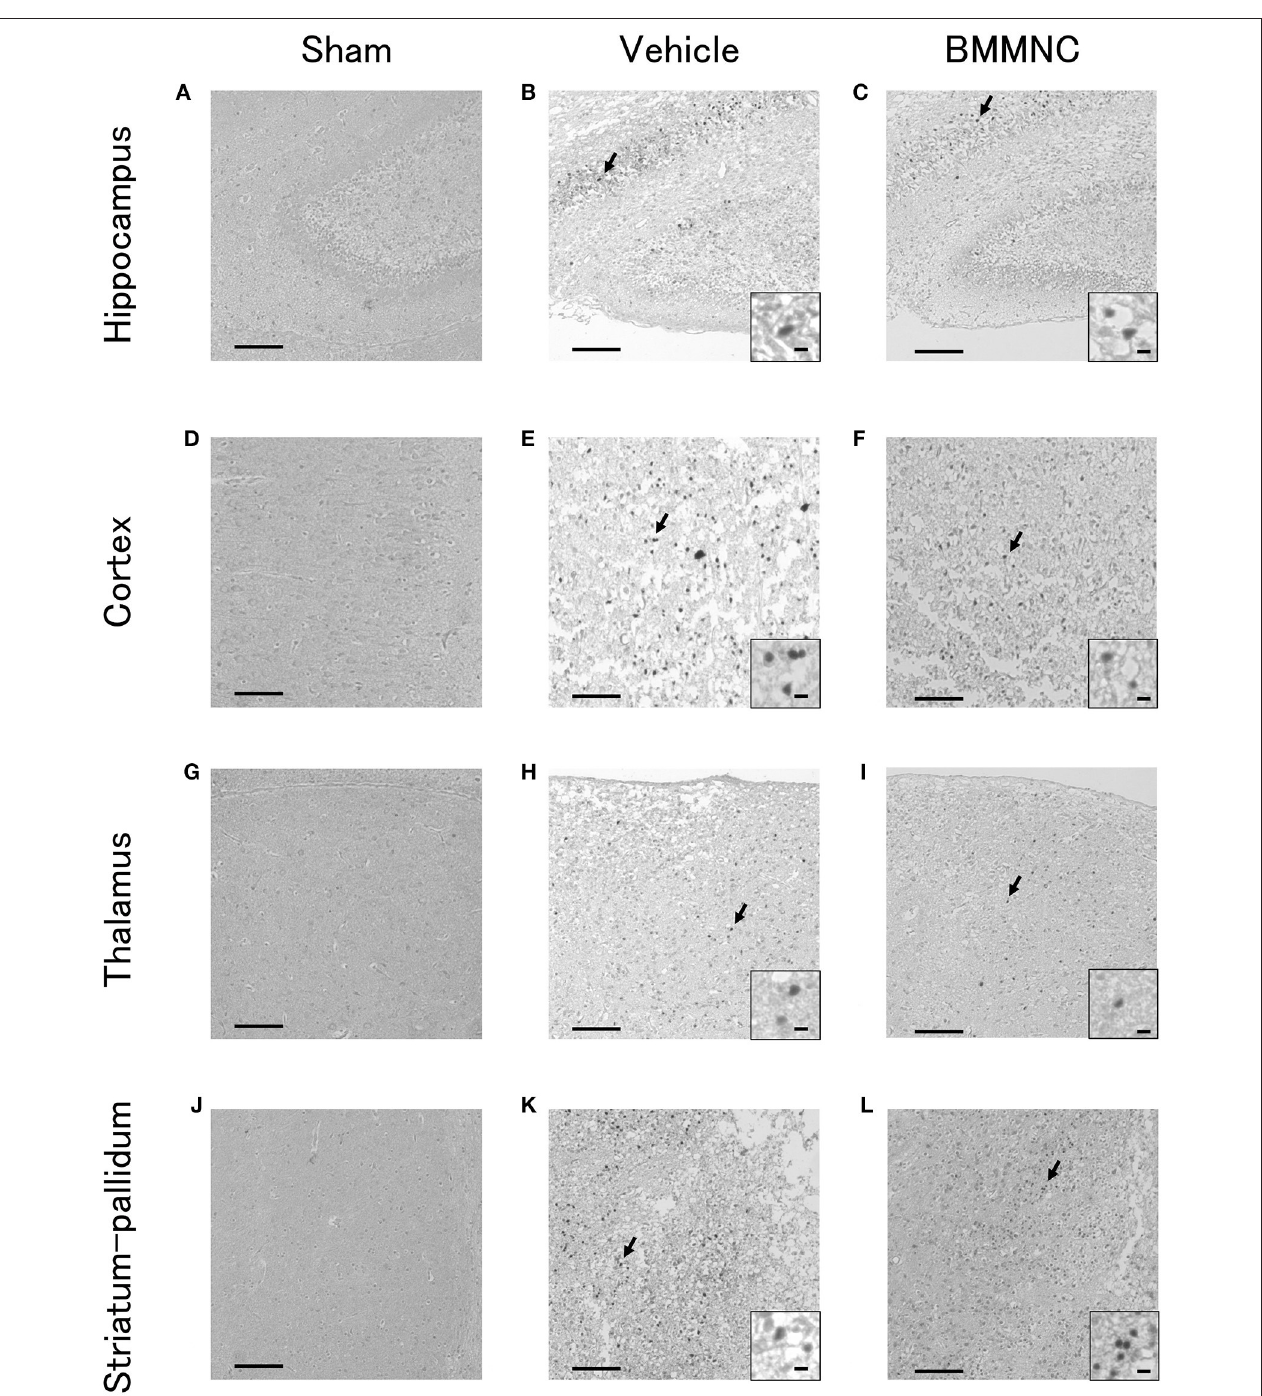
FIGURE 3 | Representative photomicrographs of active caspase-3-positive cells in the hippocampus (A–C) , cortex (D–F) , thalamus (G–I), and striatum-pallidum (J–L) 48h after HI. Bar = 100 µ m. Insets show higher magnification views ( × 400, bar = 5 µ m).